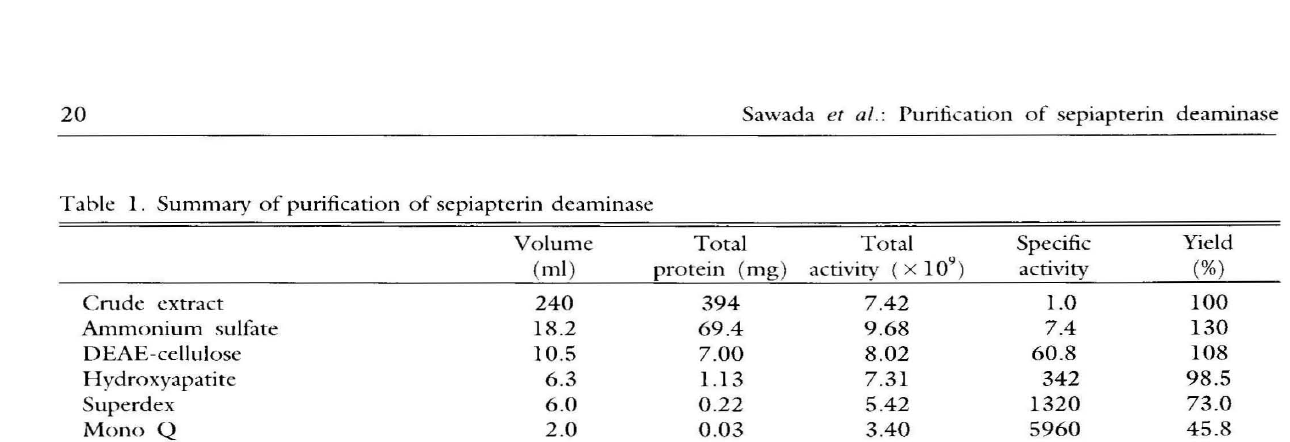
Table 1. Summary of purification of sepiapterin deaminase